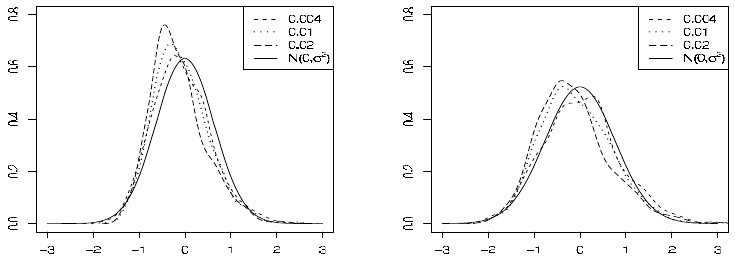
Figure 1. The true density under H 0 (solid line) and three kernel density estimators (with h = { 0 . 004 , 0 . 01 , 0 . 02 } ) for the simulated statistic T n under H 0 for the independent case with n = 1000 and 1000 replications. Kernels used in graphics are 1) N (0 , 1) (left plot) and 2) U [ − 1 , 1] (right plot), σ 2 is such as given in Theorem